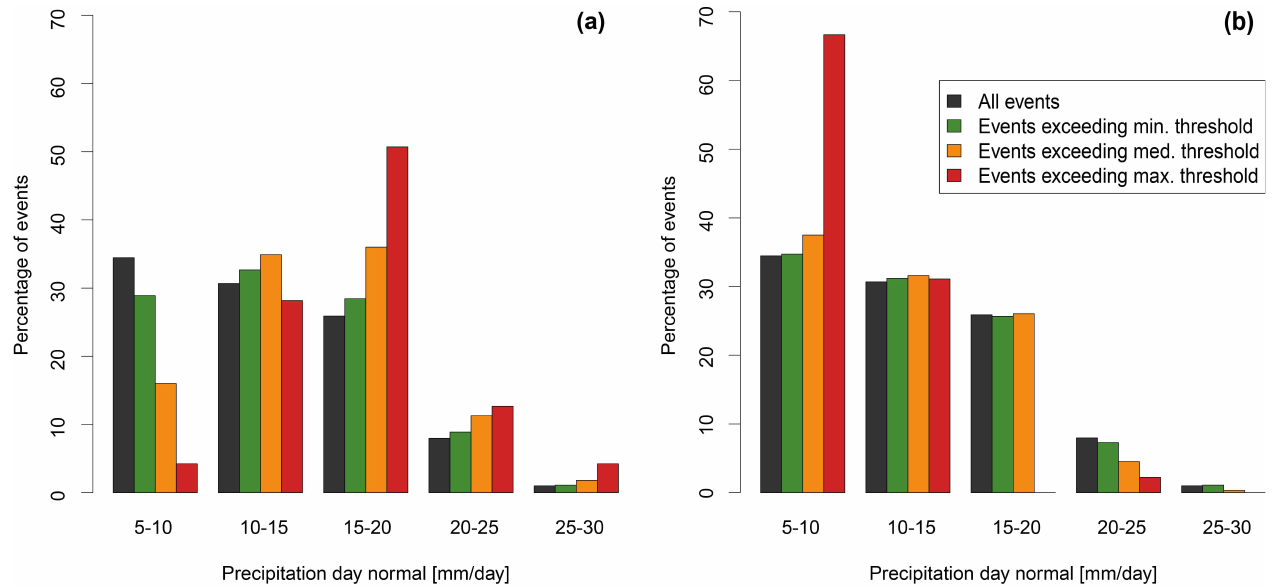
Fig. 10. Percentage of events captured by the absolute thresholds (a) and the normalized thresholds (b) according to precipitation day normal (PDN) classes: 5–10mm, 10–15mm, 15–20mm, 20–25mm, 25–30mm. Dark bars show the distribution of the entire number of events over the five classes, while the colored bars show the percentage of those events captured by the minimum, medium and maximum thresholds in each class